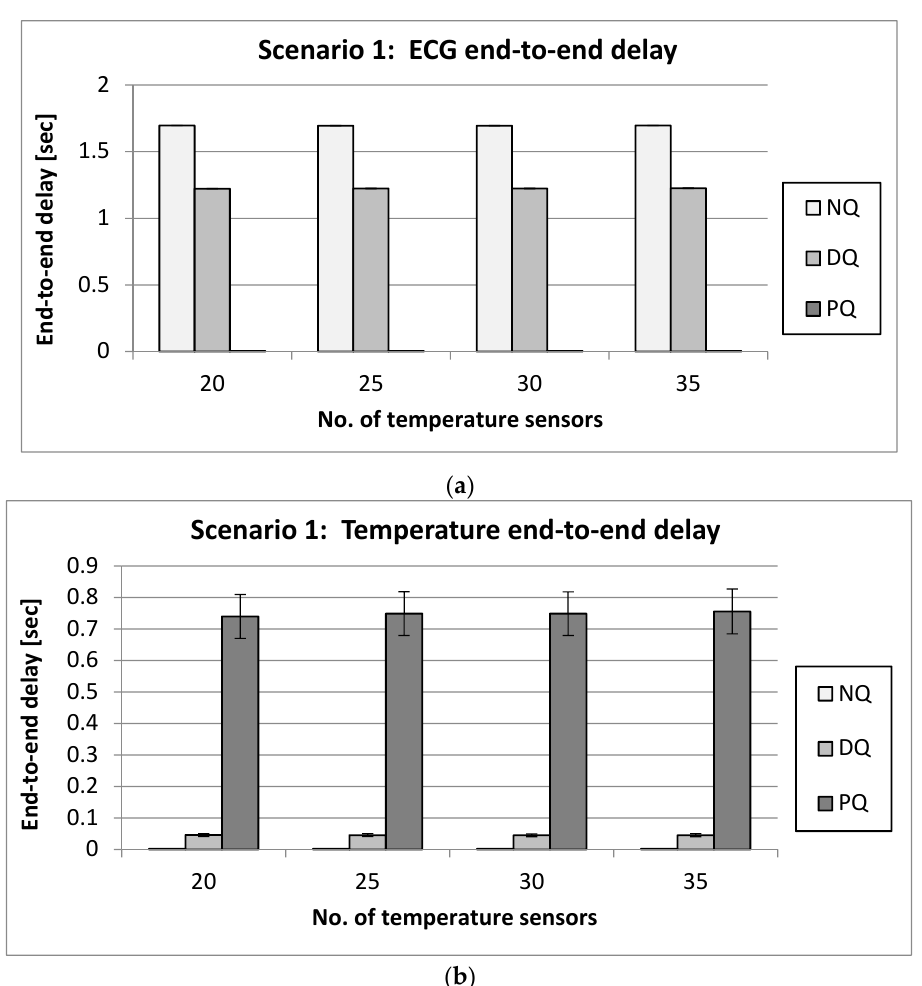
Figure 6. Average end-to-end packet delay results comparison for various data traffic types .